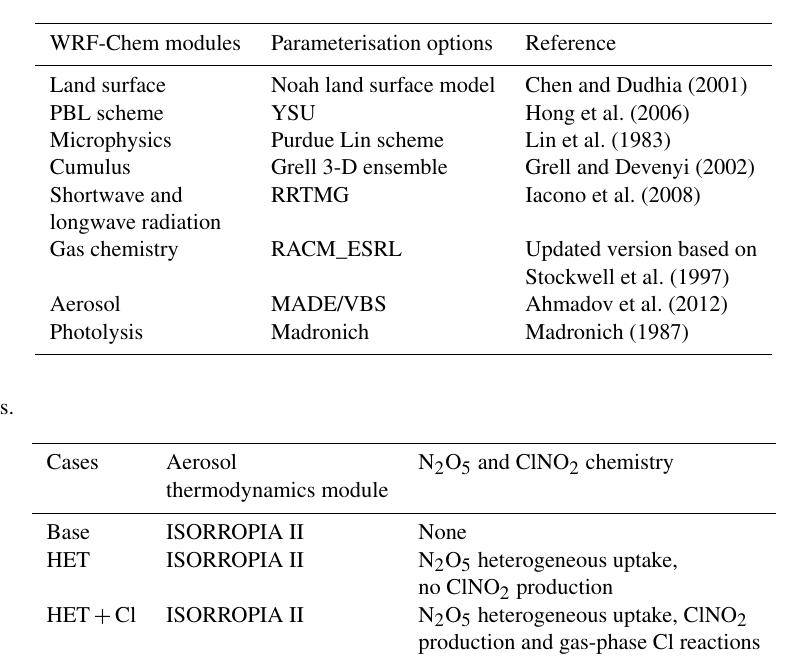
Table 1. Model configuration.